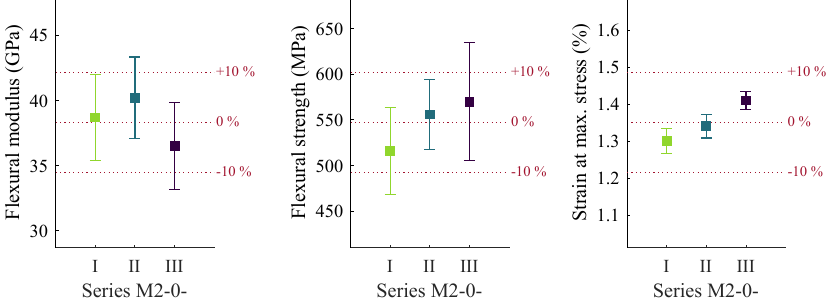
Figure 11. Comparison of the quantified bending properties of the CF/PA6 specimens in longitudinal direction (0° fiber direction) in terms of mean value and standard deviation. Percentage comparison refers to the common mean value of all specimens.